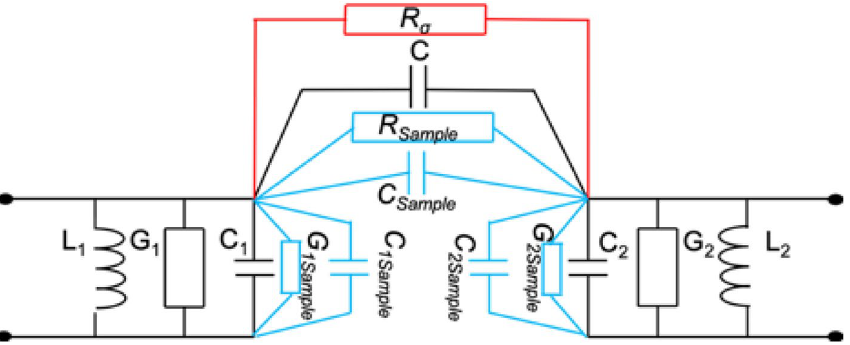
Figure 7. Lumped-element model of the